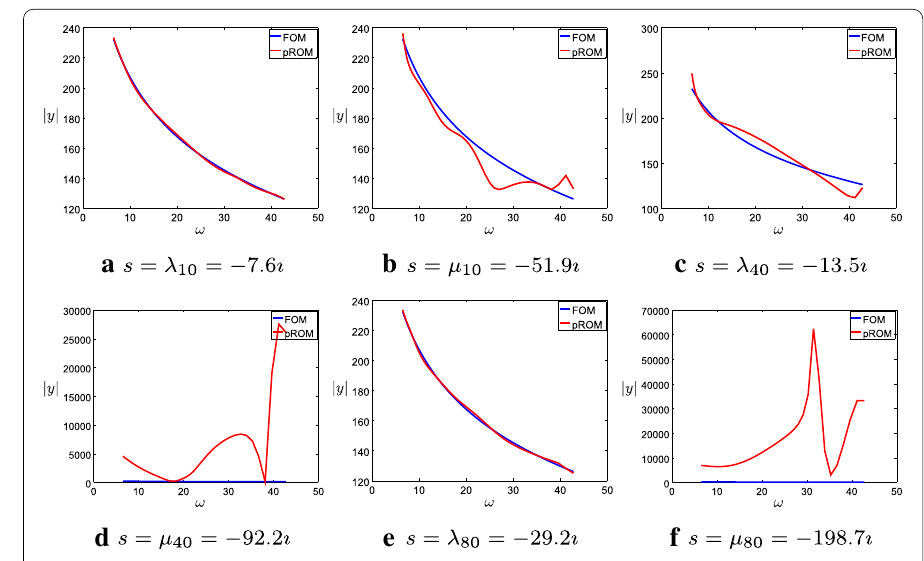
Fig. 6 Interpolation of Loewner ROMs built with individual bases. The nonparametric Loewner ROMs are built in the compressed form with different frequency shift s and they are interpolated matrix-wise directly using (46). The FRFs at p ∗ = 65 . 51 are shown in the figure